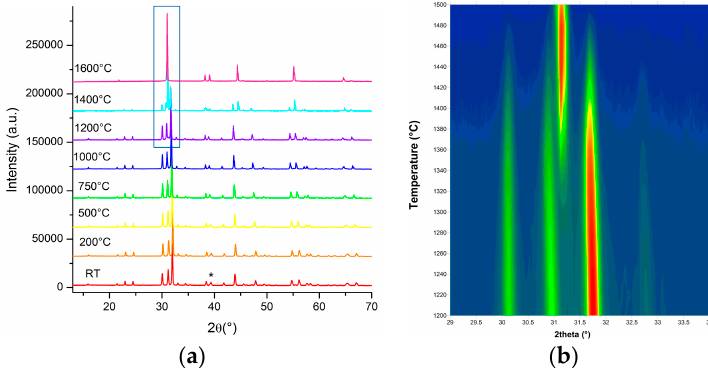
Figure 2. Phase transition from orthorhombic Sr 2 ScGaO 5 (SSGO) with brownmillerite structure towards the cubic oxygen-deficient perovskite obtained by temperature-dependent X-ray powder diffraction using a heating rate of 2 °C/min (the diffraction peak at 39° is from Pt sample holder) (RT: room temperature) ( a ); The outlined part is shown as a 2D-intensity plot ( b ), indicating that the transformation spans a range of more than 150 °C.